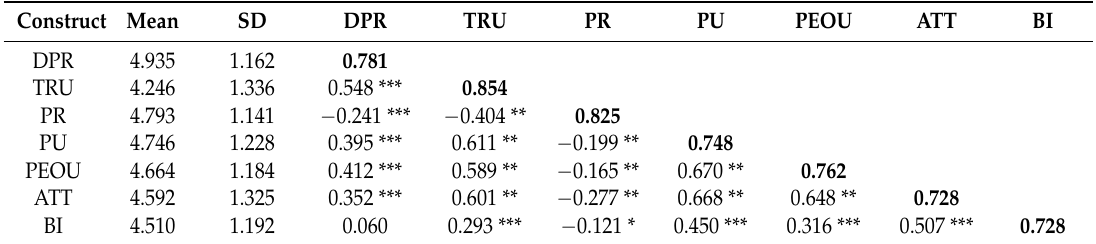
Table 3. Means, standard deviations, and correlations of the